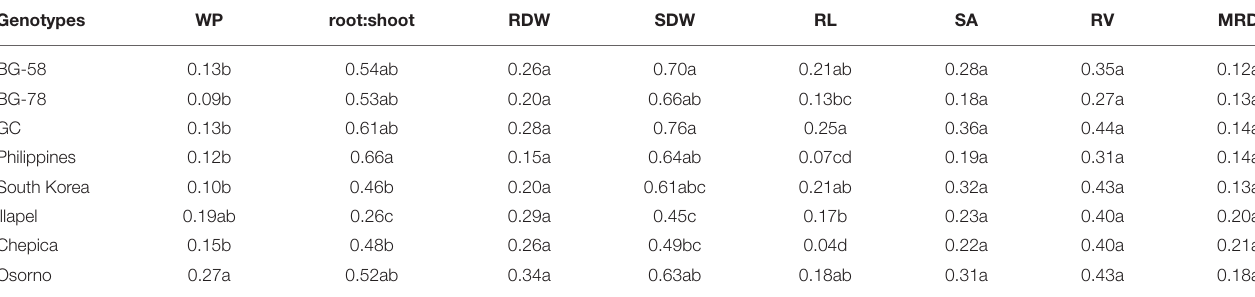
TABLE 3 | Relative distance plasticity index (RDPI) considering water productivity (WP), root and shoot biomass (RDW and SDW, respectively) and root traits (RL, Root length; MRD, Mean Root Diameter; RV, Root Volume; SA, Surface Area), assessed in eight bottle gourd genotypes subjected to a water-deficit condition.